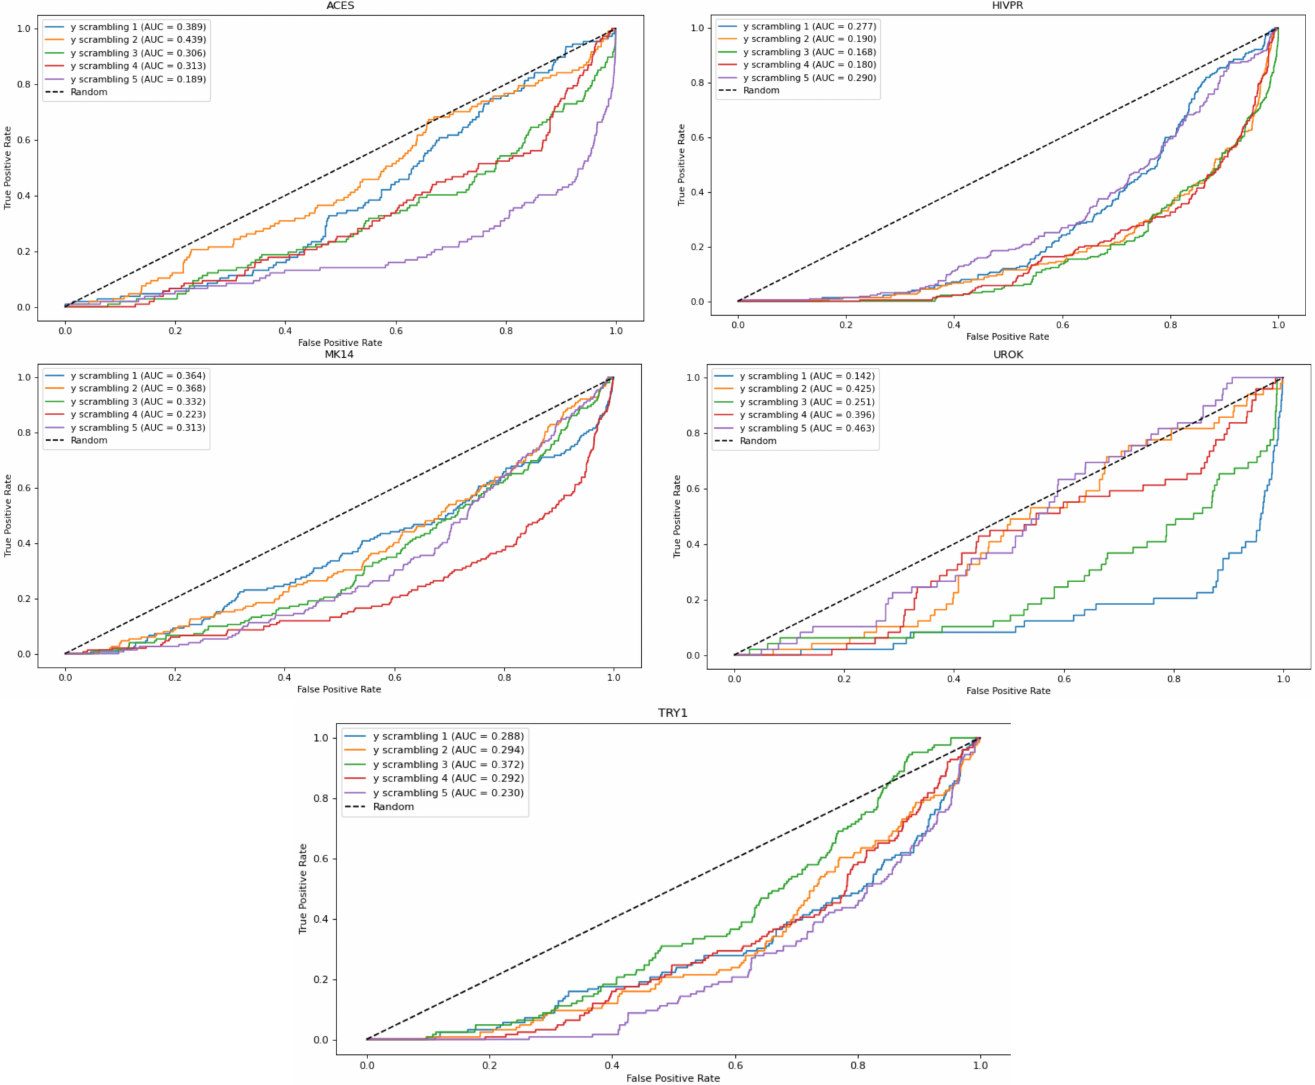
Figure 2. ROC curves obtained from the EOA models derived from the scrambled sets. In all cases AUC values are below 0.5, indicating performances lower than